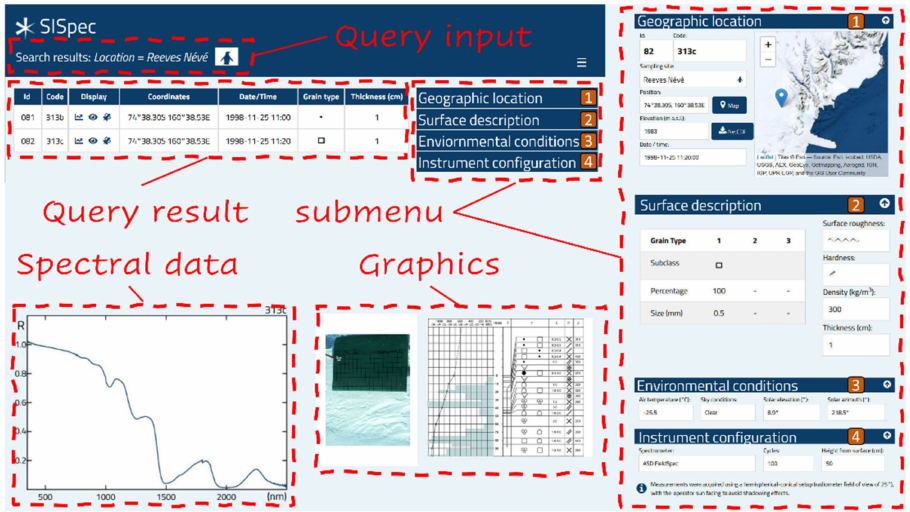
Figure 5. Results of the query by location and available information of the Reeves N é v é site. Informa- tion sections rearranged for clarity.